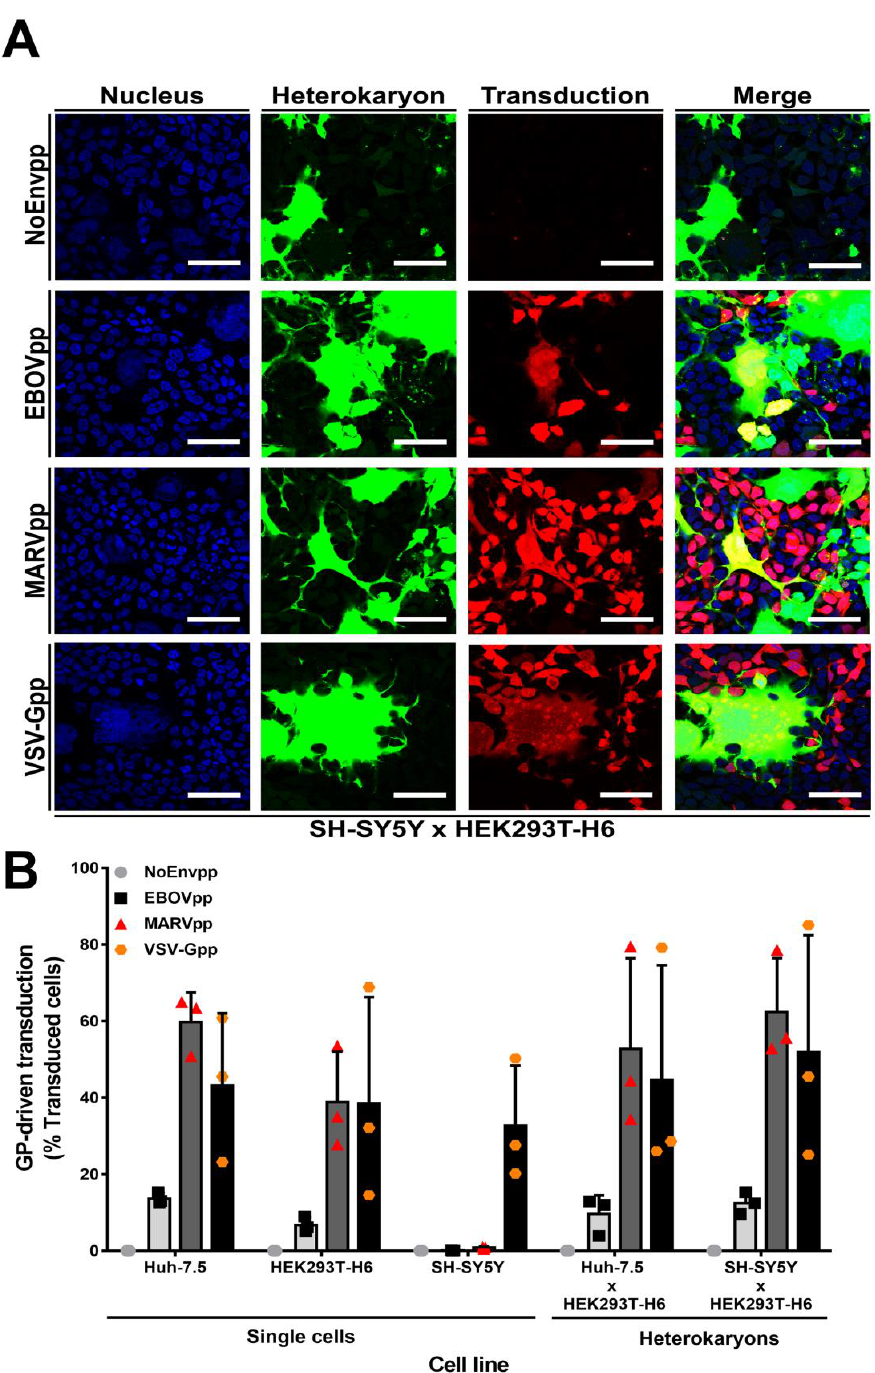
Figure 4. SH-SY5Y cells do not express a dominant entry restriction factor. Huh-7.5 or SH-SY5Y cells stably expressing the tetracycline-inducible Tet On 3G transactivator protein were cocultured with HEK293T-H6 cells stably expressing transactivator-inducible ZsGreen1 green fluorescent protein for 24 h. Cells were chemically fused with PEG. One hour after fusion, cells were transduced with NoEnv, EBOV, MARV, or VSV-G pseudoparticles encoding mCherry for 6 h at 37 °C. Seventy-two hours post transduction, cells were fixed with 3% PFA and analyzed for heterokaryon formation (ZsGreen1 protein expression) and susceptibility to pseudoparticle infection (mCherry protein expression). ( A ) Confocal microscopy images of one representative experiment with SH-SY5Y and HEK293T-H6 cells. Scale bars = 50 µ m ( B ) Quantification of transduced cells by flow cytometry. Left-hand side of graph represents transduction percentage of single cell line controls and right-hand side from heterokaryons